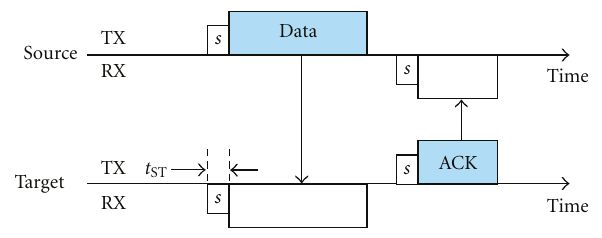
Figure 8: The activity of radio in